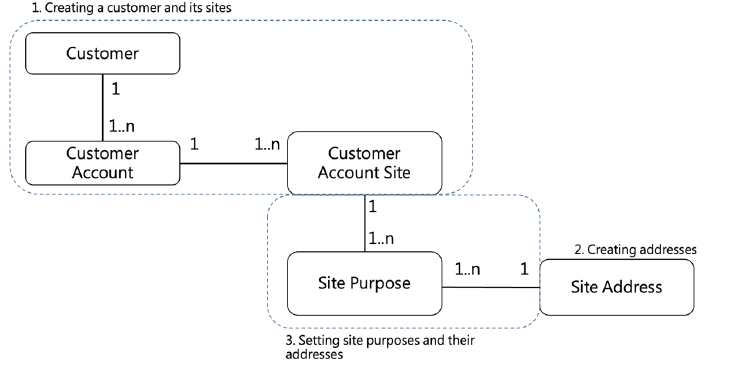
Fig. 3. The contents of a practice unit are divided into several sequential sections according to the parent-child entity rela- tionships in the customer data model to reveal to students the data flow between the